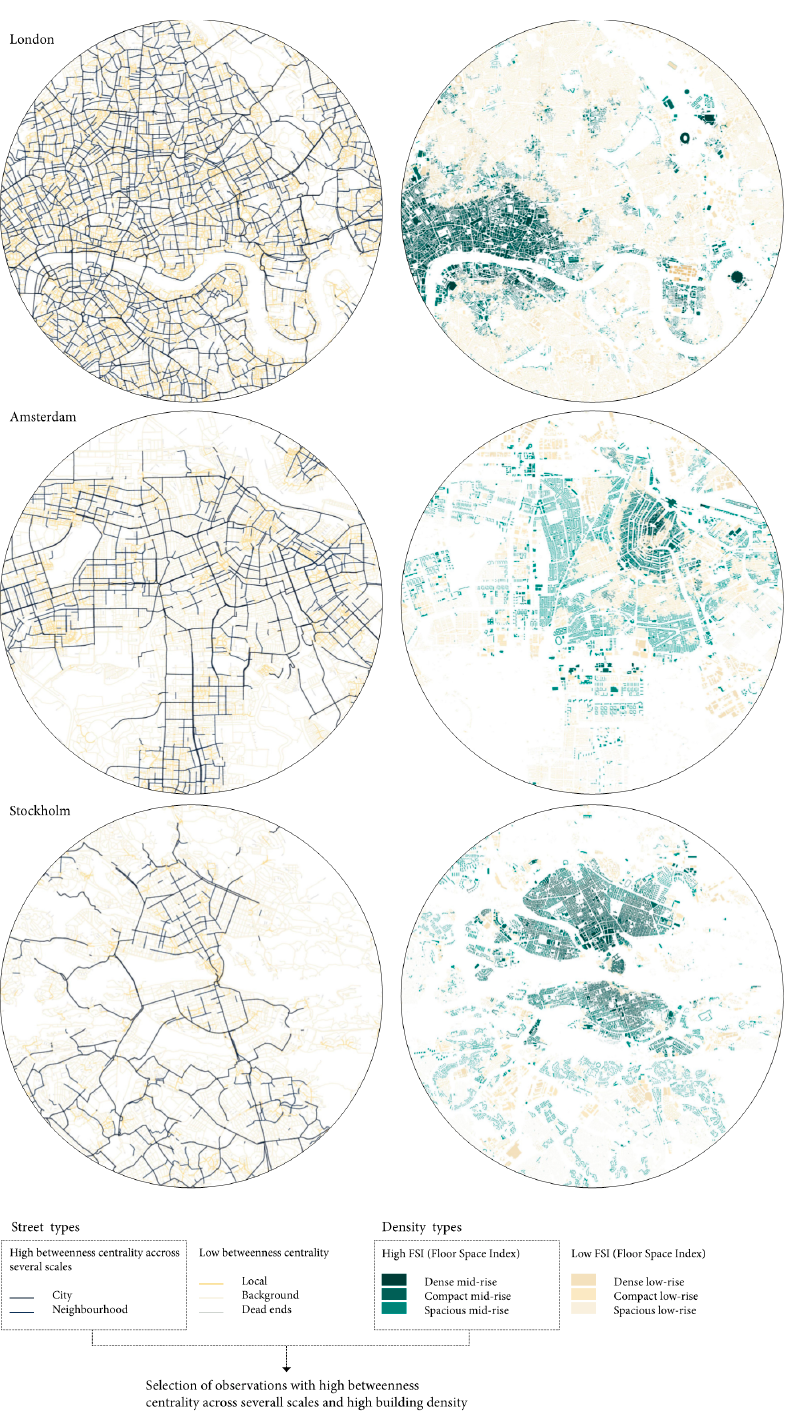
Figure A5. London, Amsterdam and Stockholm. Overview of street centrality types (left) and built density types (right) [15,63] where observations that correspond to high betweenness centrality and high built density are selected for the statistical model in order to make sure these variables remain constant and do not influence variations in the concentration of economic activities.